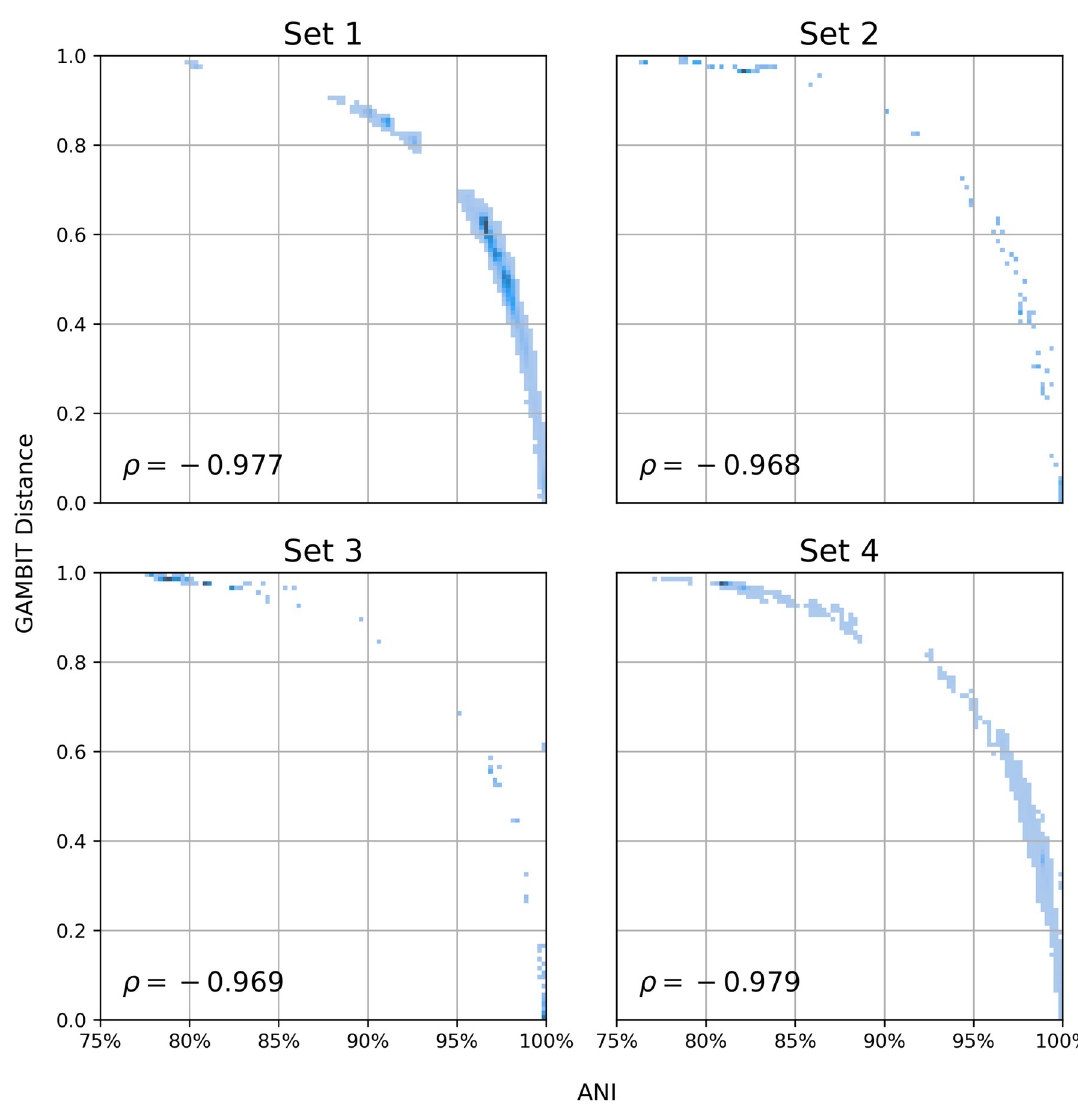
Fig 1. Relationship between GAMBIT distance and ANI (Average Nucleotide Identity) for all pairs of genomes in data sets 1–4. The relationship is nonlinear but very close to monotonic as measured by Spearman correlation (shown in the bottom left corner of each subplot). ANI was calculated using the FastANI tool (see Materials and methods) with default parameter values. GAMBIT distances were calculated using the same parameter values as in the RefSeq reference database (k = 11, prefix = ATGAC). As FastANI only reports ANI values greater than ~80%, the fraction of total pairwise comparisons shown here were 100%, 5.5%, 7.4% and 47.4% for data sets 1–4 respectively. GAMBIT distances for comparisons with no ANI value to compare to are shown in S2 Fig.